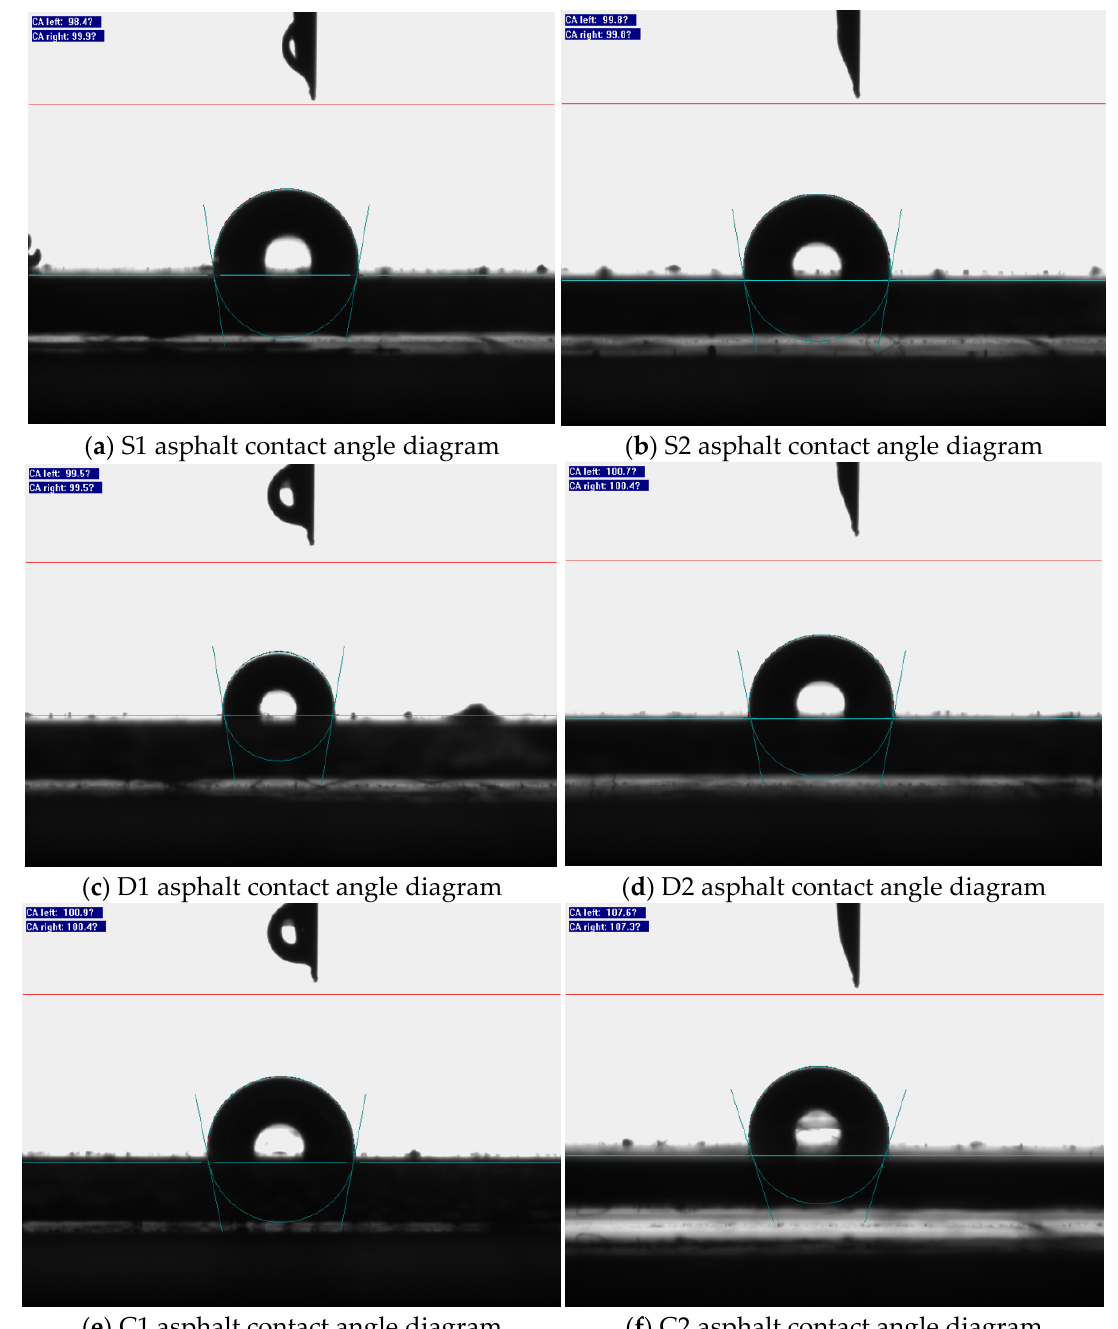
Figure 8. Contact angle diagram.